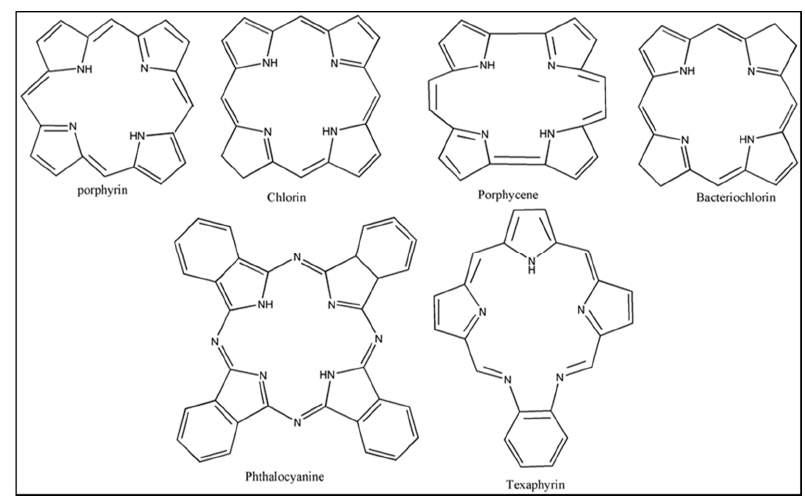
Figure 2. Examples of porphyrinoids: Porphyrin, Chlorin, Porphycene, Bacteriochlorin, Phthalocyanine, Texaphyrin.